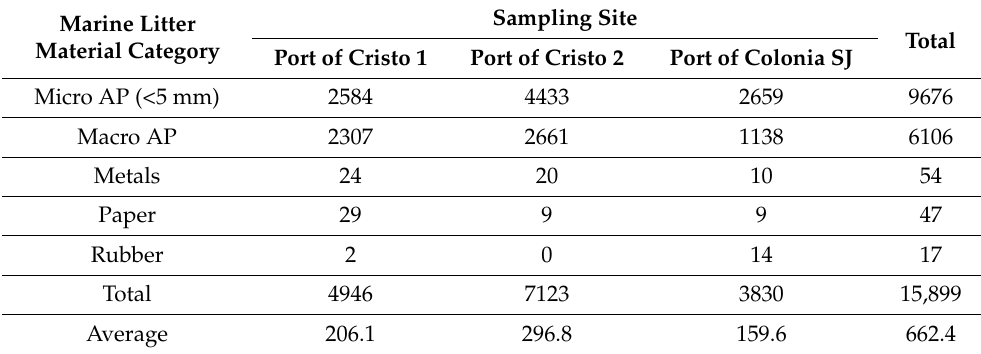
Table 1. Total number of collected items per main material litter